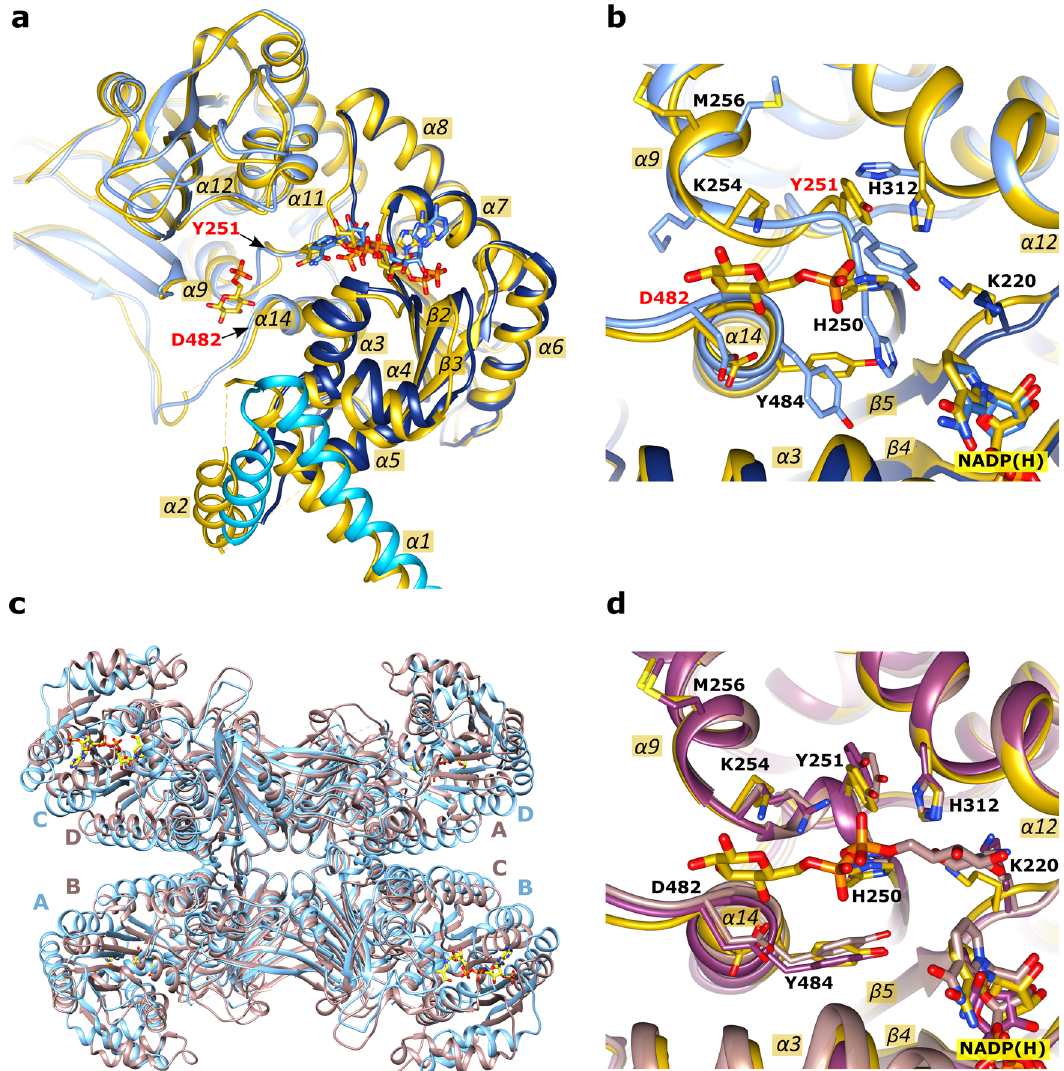
Fig. 6 G6P-induced rearrangements of Ld G6PD wt and structural comparison with orthologues. Superimposition of the NADP(H)-complexed structure (PDBID: 7ZHU; blue) with the structure complexed with G6P and NADP(H) (PDBID: 7ZHZ; yellow). Residue Y251 (red) marks the G6P-induced active site shift of the loop comprising residues H250-K254. a The superimposed dimers (only monomer B is shown) show the G6P-induced shift of the N- and the “ Rossman-like ” domain. Residue D482 (red) marks the end of the fl exible loop (T471-D482), connected to α 14 b Active site close-up. Here, monomers B of both structures are superimposed. The superimposition shows the different sidechain conformations of residues lining the G6P binding site and the rearrangement of region H250-K254. c, d Comparison with orthologues. c Superimposition of the T. cruzi G6PD tetramer with the Ld G6PD 60-562 mutant. Both enzymes were crystallized lacking the helical N-domains. The apo-structure of the Tc G6PD tetramer (PDBID: 6D23) with subunits A-D is colored brown and that of the NADP(H)-complexed Ld G6PD 60 – 562 tetramer (PDBID: 7ZHX) light blue. d Superimposed active sites of the Ld G6PD structure (with bound G6P and NADP(H); PDBID: 7ZHZ; yellow) with the Tc G6PD (with bound G6P; PDBID: 5AQ1; brown) and Hs G6PD structure (with bound NADP + ; PDBID: 2BH9; purple). Figure d is shown in the same orientation as b . Respective α -helices and β -sheets are